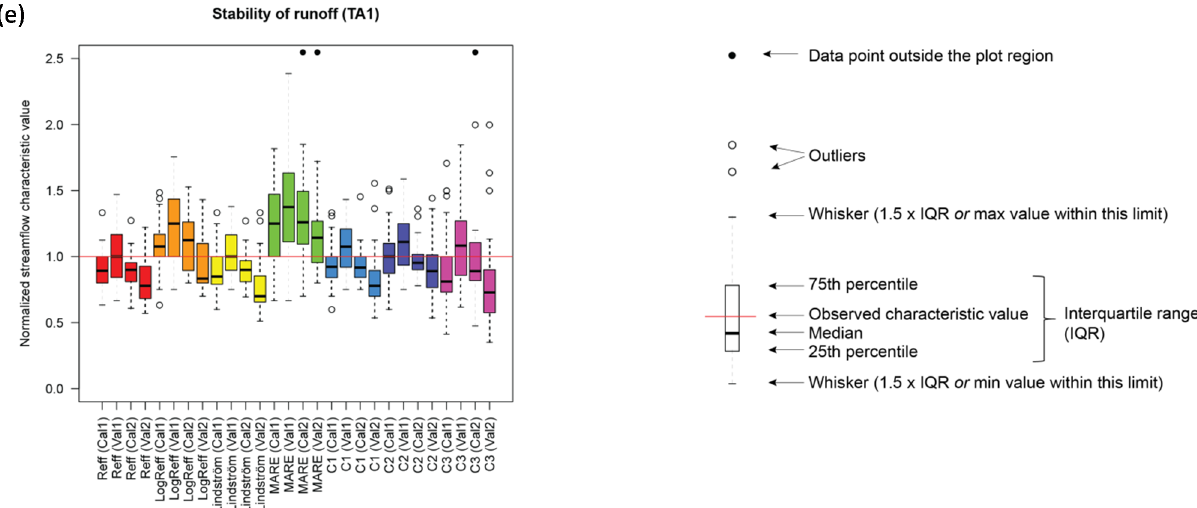
Figure 3. Normalized median flow characteristic values for five different flow characteristics: ( a ) DH16 (Variability in high-flow pulse duration); ( b ) FL2 (Variability of low-flow pulse count); ( c ) MA41 (Mean annual runoff); ( d ) MH10 (Maximum October runoff) and ( e ) TA1 (Stability of runoff). Each color corresponds to an objective function. Per objective function, the four boxplots represent (from left to right) calibration period 1 (Cal1), validation period 1 (Val1), calibration period 2 (Cal2) and validation period 2 (Val2). Each boxplot is based on 27 normalized median flow characteristic values, one value for each of the 27 catchments. Medians were computed over 100 runs per catchment. Normalization was carried out by dividing the median values by the corresponding observed flow characteristic